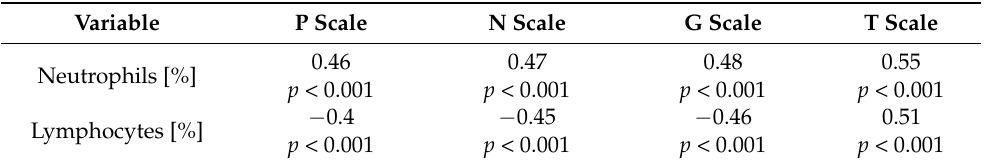
Table 4. Relationship between the percentage of neutrophils and lymphocytes in the studied group of people and their scores for individual scales.